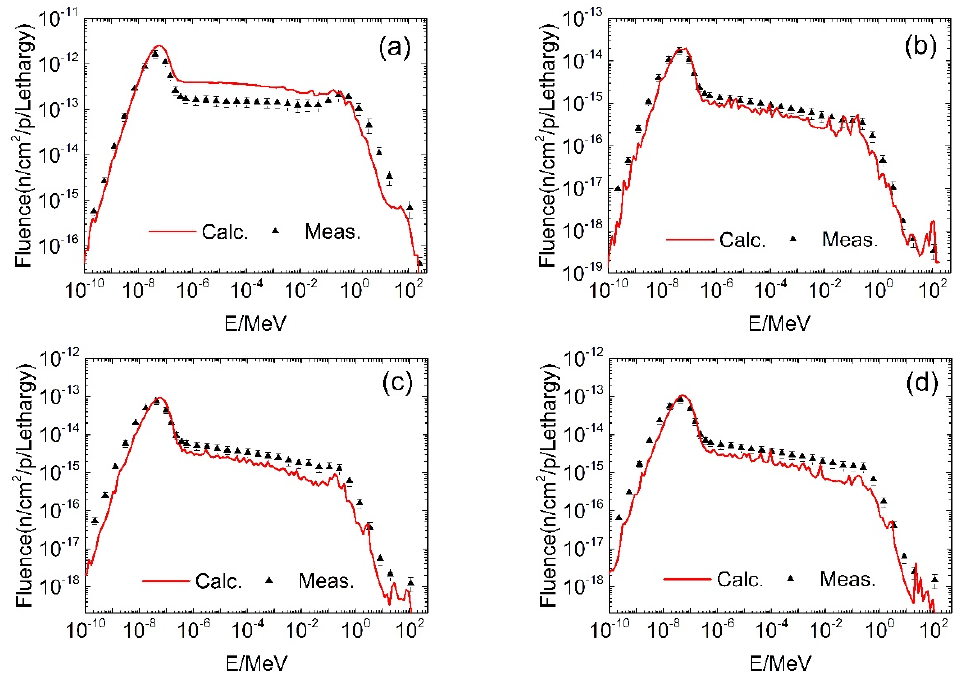
Figure 4. Comparisons between measured and simulated neutron spectra, ( a ) location A without PE plate; ( b ) location B without PE plate; ( c ) location B with a 1 cm PE plate; ( d ) location B with a 2 cm PE plate.